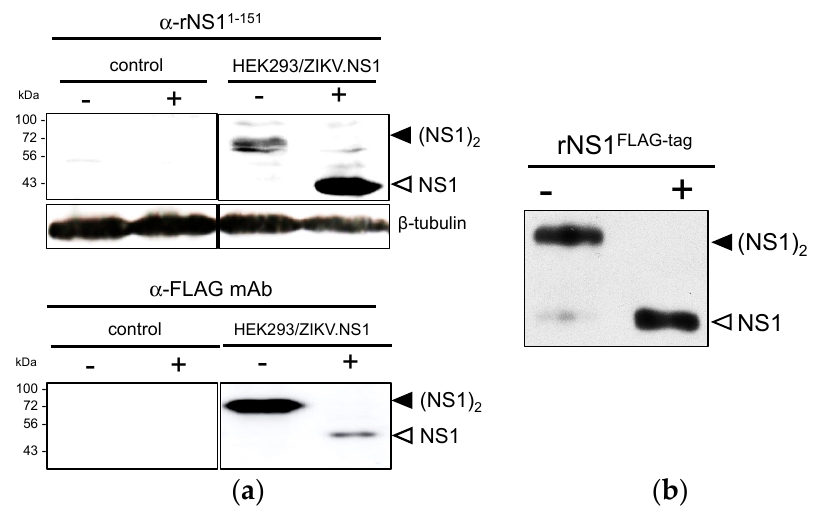
Figure 2. Expression of recombinant ZIKV NS1 protein in HEK-293 cells stably transfected with a plasmid vector. ( a ) Immunoblot analysis of rNS1 expression in RIPA lysates from HEK293/ZIKV.NS1 FLAG-tag (HEK293/ZIKV.NS1) and mock-transfected HEK293 (control) cells. Samples were heat-denatured (+) or not ( − ) before immunoblotting with rat anti-NS1 serum ( α -rNS1 1–151 ) or mouse anti-FLAG mAb ( α -FLAG mAb). Detection of β -tubulin served as protein loading control; ( b ) Samples of purified rNS1 FLAG-tag were heat-denatured (+) or not ( − ) and then analyzed by immunoblotting with anti-FLAG mAb. The bands corresponding to NS1 dimer (black arrow head) and NS1 monomer (open arrow head) are indicated to the right of the blot.